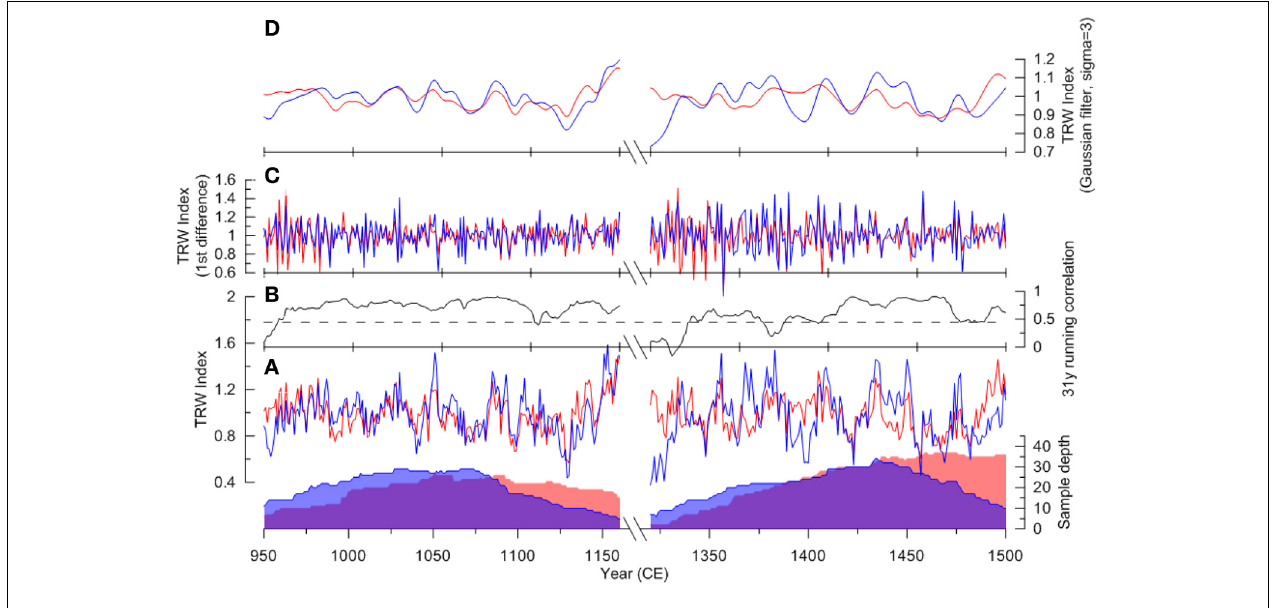
FIGURE 5 | Comparison of raw (A), interannual (C), and decadal (D) growth patterns between the drywood (blue) and the subfossil (red) composite tree-ring width (TRW) chronologies in